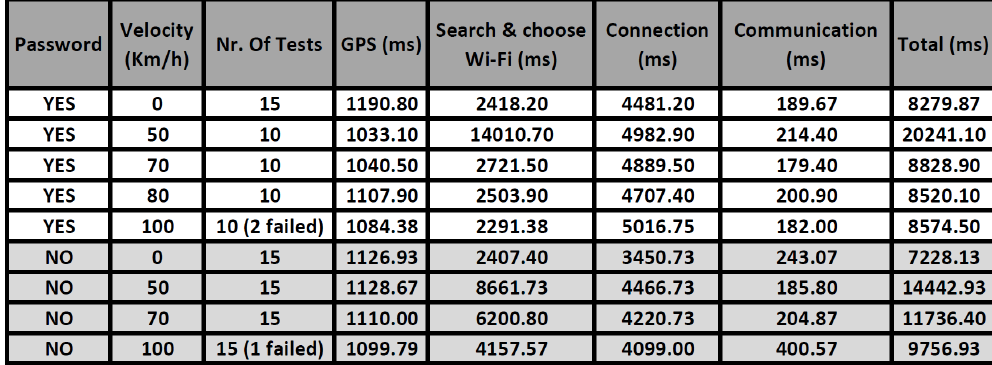
Figure 16. Results from tests in real